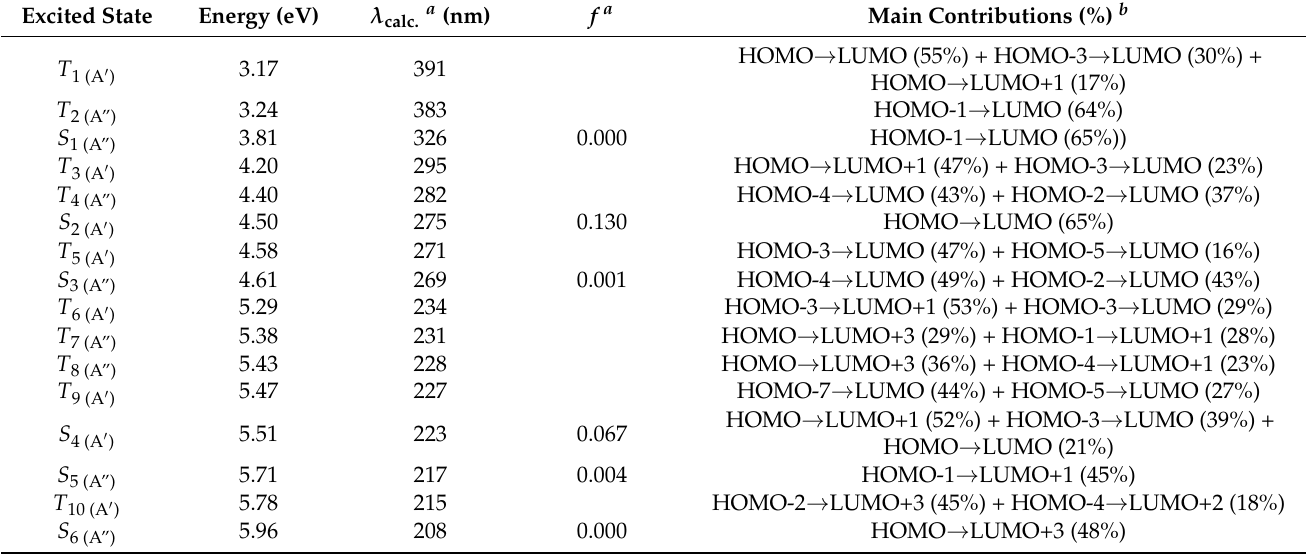
Table 5. Vertical excitation energies, wavelengths, oscillator strengths and main contributions to the excited states of BPCA ( trans conformer) calculated at the TD-DFT(CAM-B3LYP)6-311+G(d,p) level in